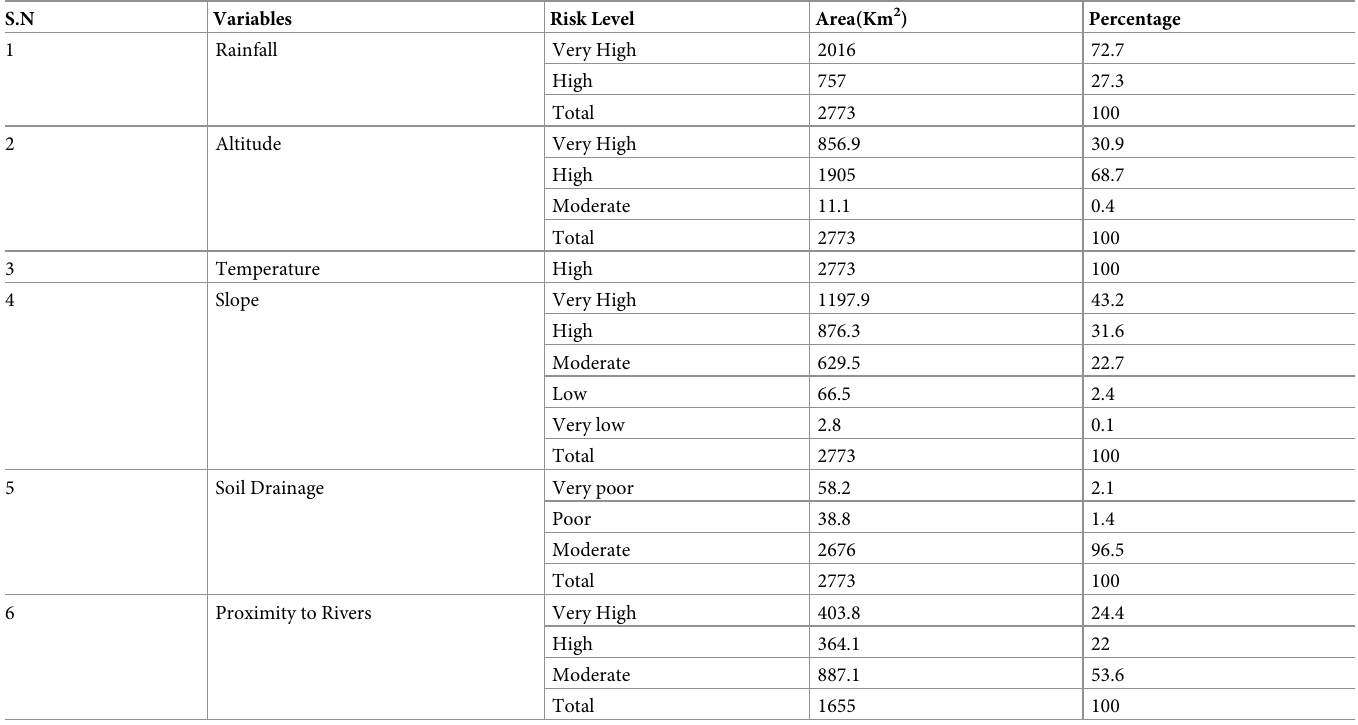
Table 3. Summary of the malaria risk level along the variables. S.N